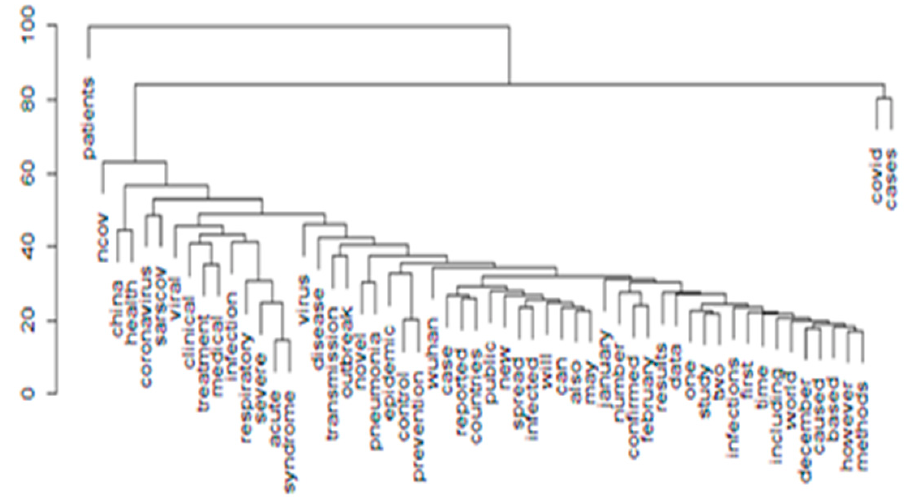
Figure 2. Cluster dendrogram.